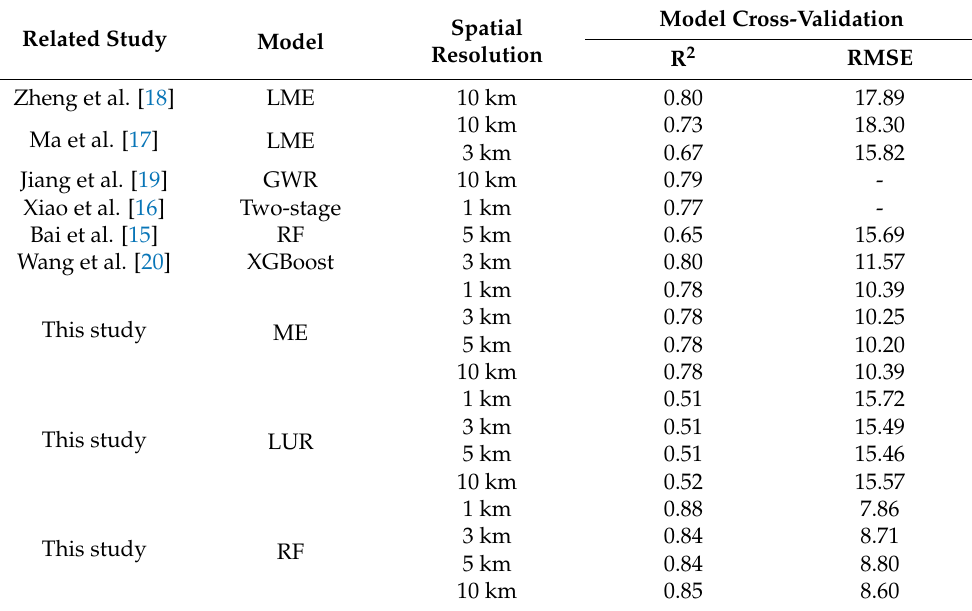
Table 1. Comparison of performances of different AOD-based PM 2.5 retrieval models in the Yangtze River Delta region.